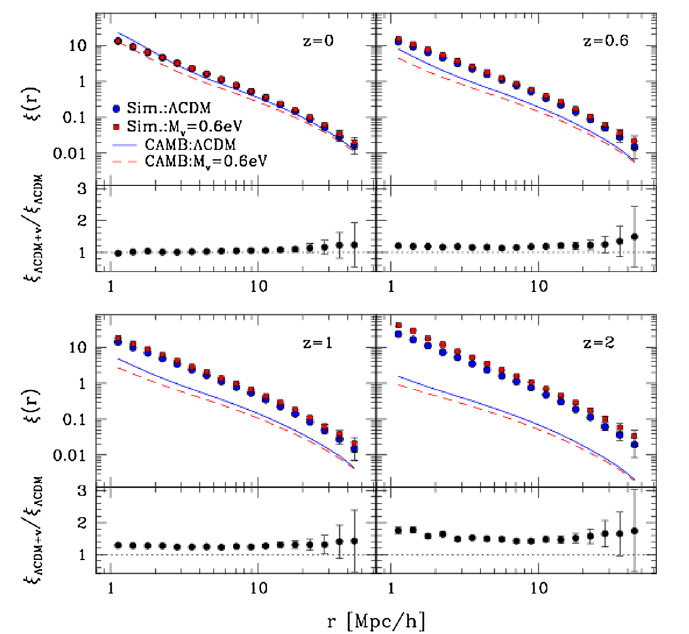
Fig.44 Realspacetwo-pointauto-correlationfunctionoftheDMhaloesinthe Λ CDM N -bodysimulation (blue circles) and in the simulation with Σ = 0 . 6 eV (red squares). The blue and red lines show the DM correlation function computed using the camb matter power spectrum with Σ = 0 and Σ = 0 . 6 eV, respectively. The bottom panels show the ratio between the halo correlation function extracted from the simulations with and without massive